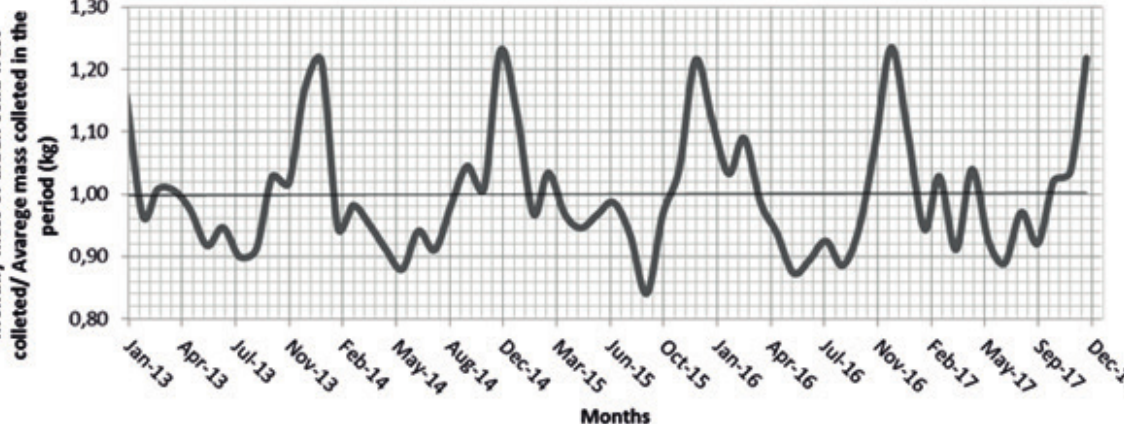
Figure 3. Evolution of HSW generation in Campo Grande in dimensionless values. Source: SISEP